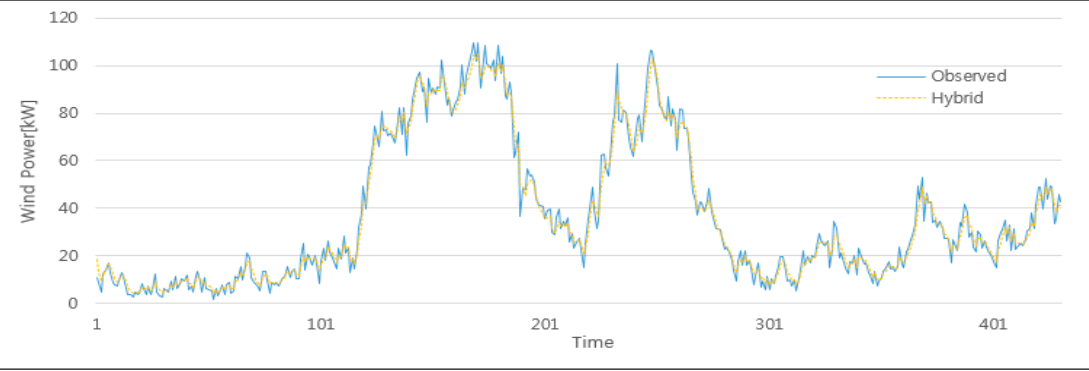
Figure 12. Comparisons between the observation and hybrid model in B region of Jeju Island.